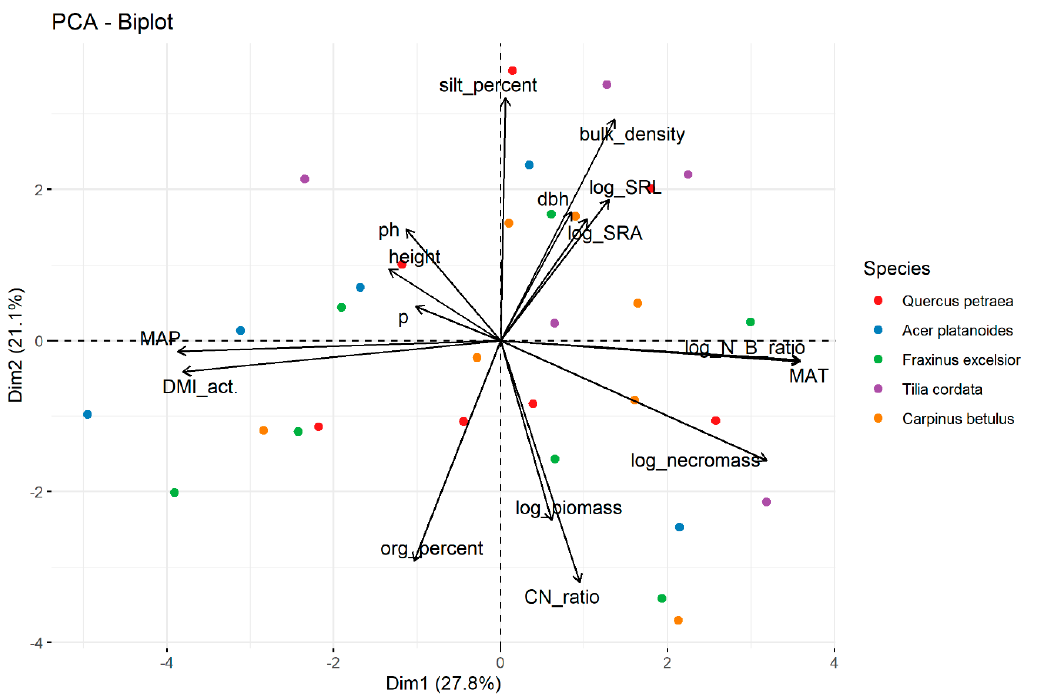
Figure A3. Principal components analysis ( PCA) biplot of the 2017 fine root inventory. All data are aggregated on site and species level.